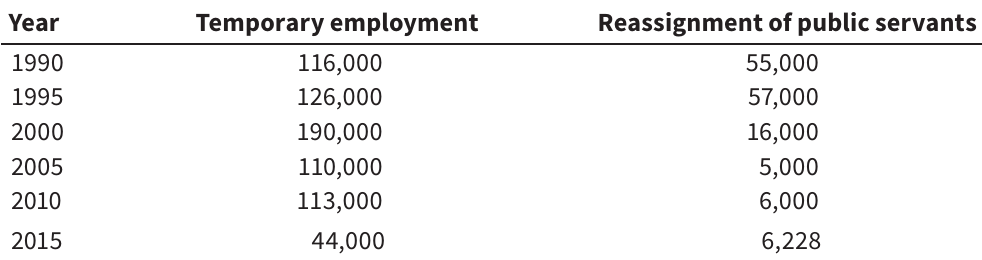
Korea census hiring and